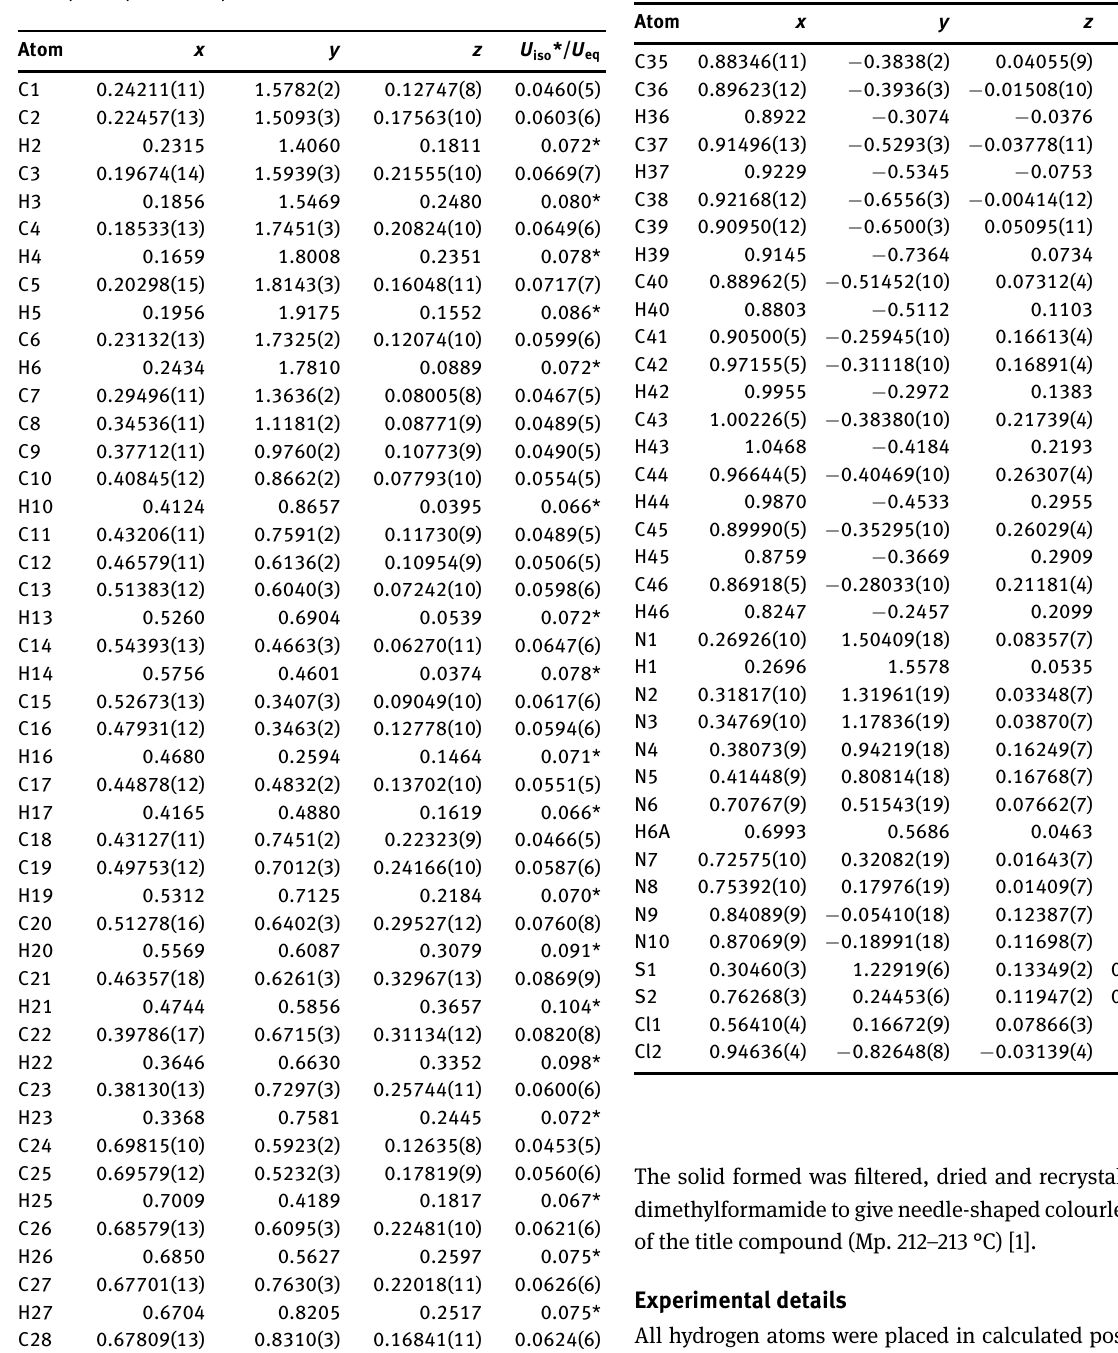
Table 2: Fractional atomic coordinates and isotropic or equivalent isotropic displacement parameters (Å 2